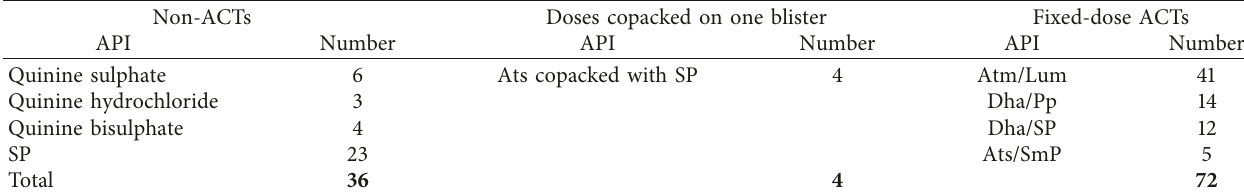
Table 1: Composition of analysed antimalarial medicines.